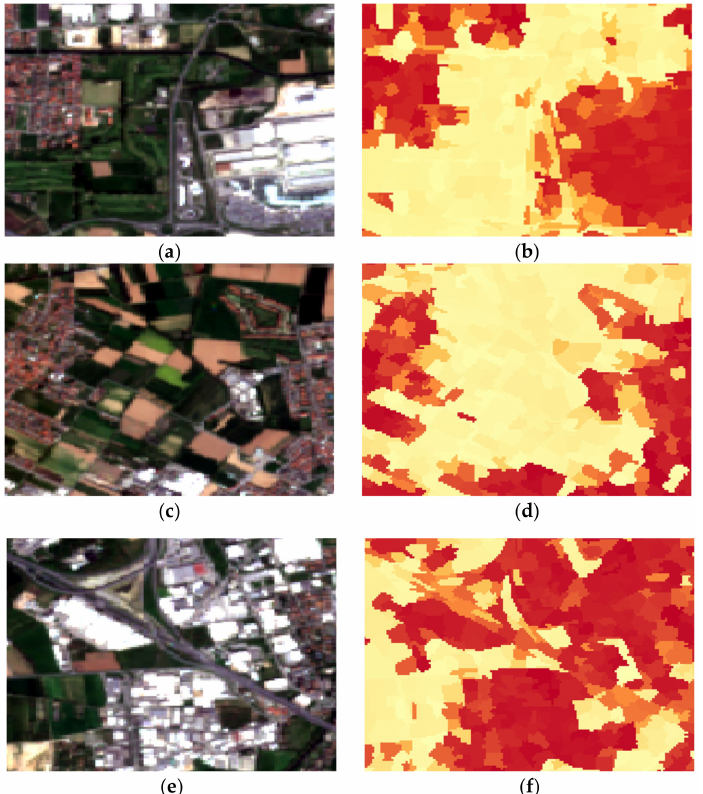
Figure 10. Lainate classification results, demonstrated for 2 km × 2 km sections. ( a , c , e ): S2 reference. ( b , d , f ): S1S2UM fuzzy classification result, where red: urban pixels, yellow: non-urban pixels.